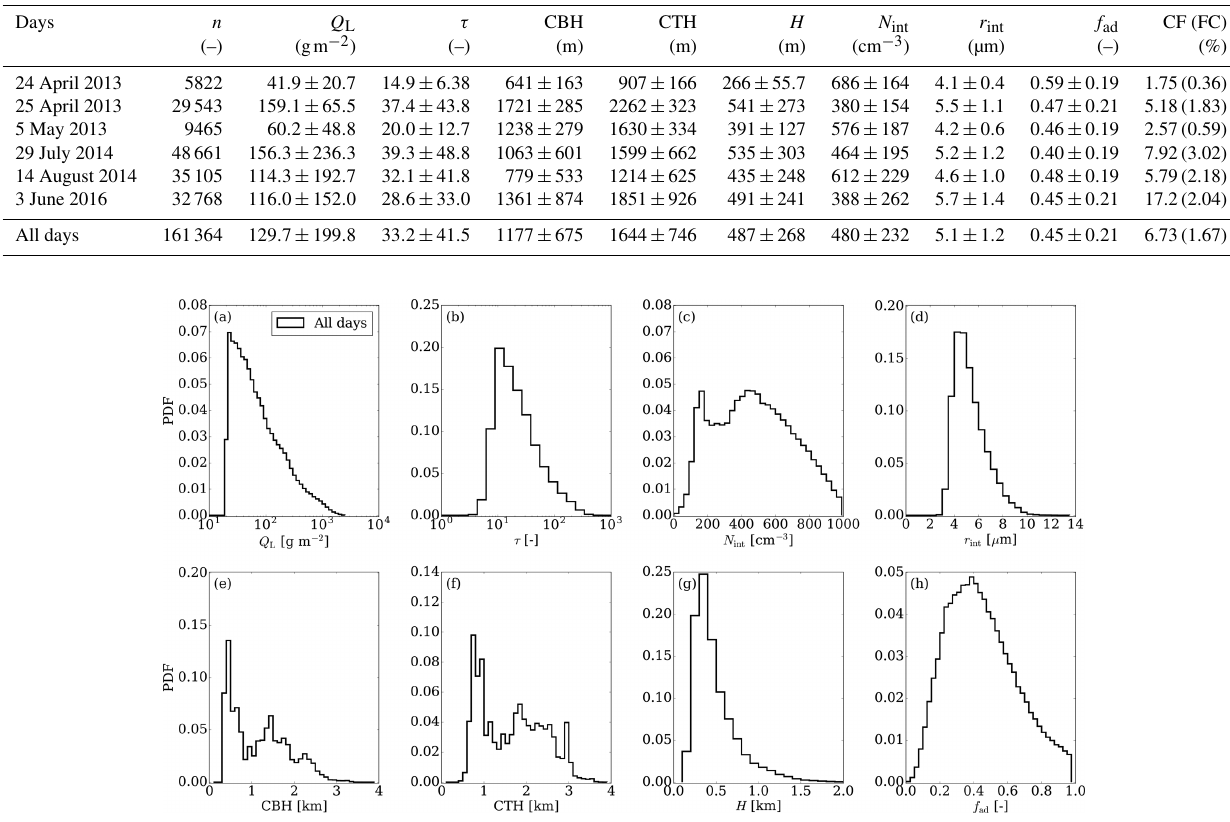
Figure 1. Histograms of cloud properties for all the case days on average as simulated by ICON-LEM: (a) Q L , (b) τ , (c) N int , (d) r int , (e) CBH, (f) CTH, (g) H , and f ad